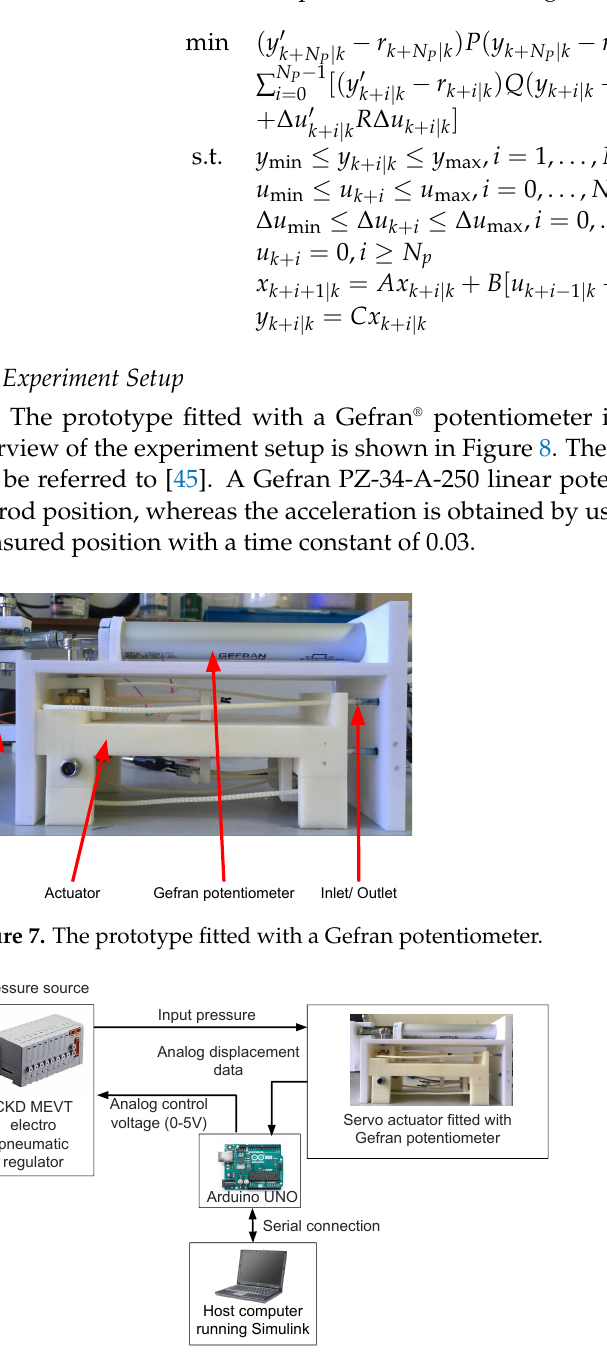
Figure 8. Overview of the experiment setup. Reprinted by permission from Springer Nature: Springer eBook [45], copyright 2021, with some